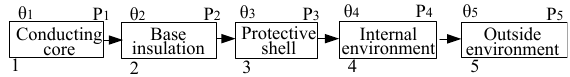
Figure 1. Structural diagram of thermal